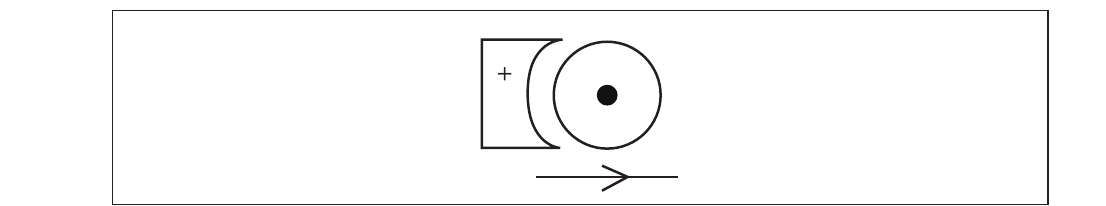
Figure 6. Elements of force -dynamics (Talmy,